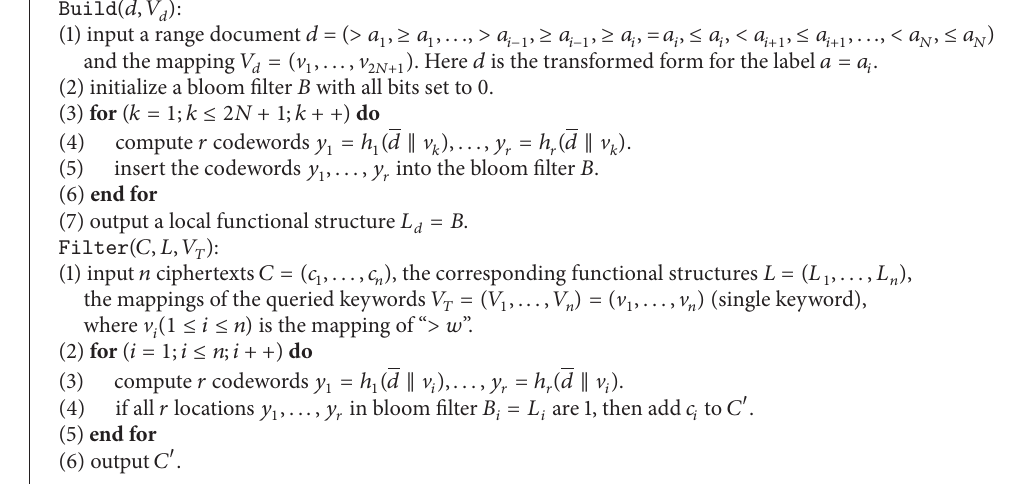
Algorithm 9: Range query